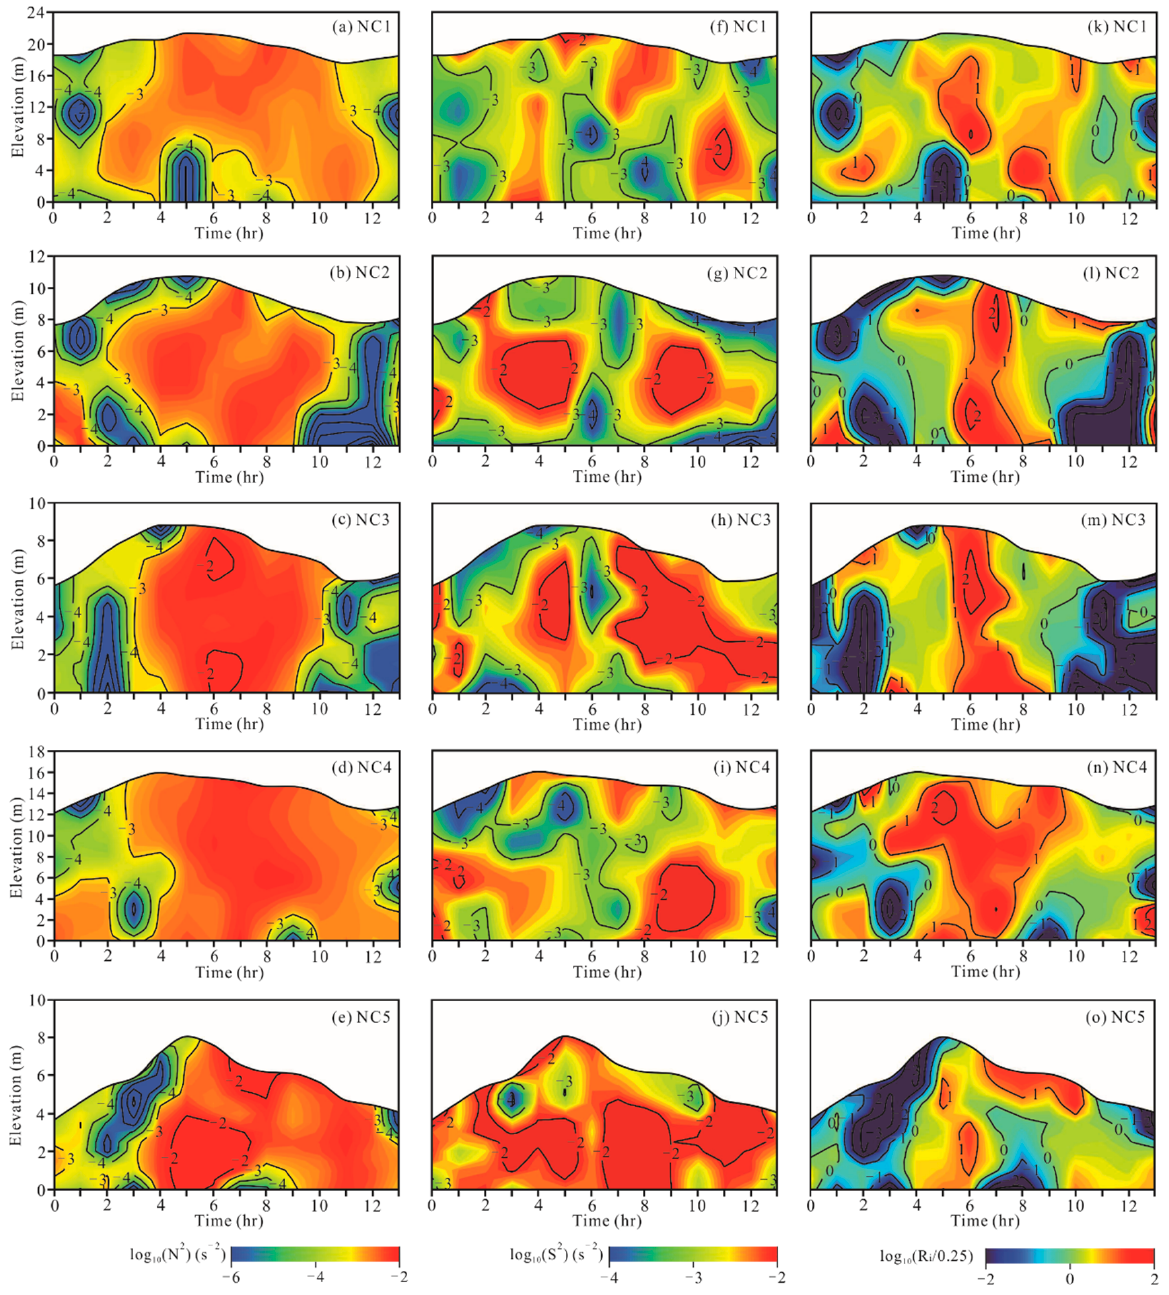
Figure 7. Temporal variations of buoyancy frequency squares, N 2 (s − 2 ) ( a – e ), mean shear squares, S 2 (s − 2 ) ( f –j), and gradient Richardson numbers, 𝑅 (cid:3036) ( k – o ), at NC1 to NC5 stations.